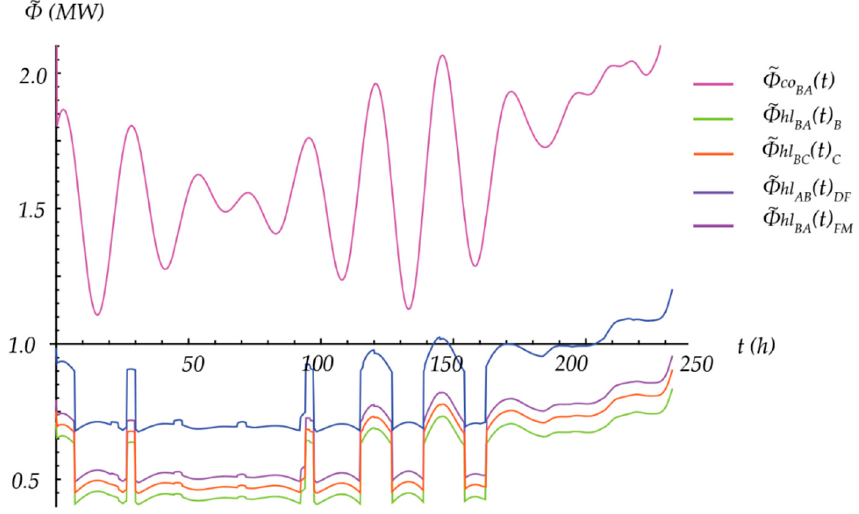
Figure 20. Unsteady cogeneration heating effect and total unsteady low-pressure heating loads for products B , C , DF and FM during the ballast voyage, from B to A for 10th transport cycle.